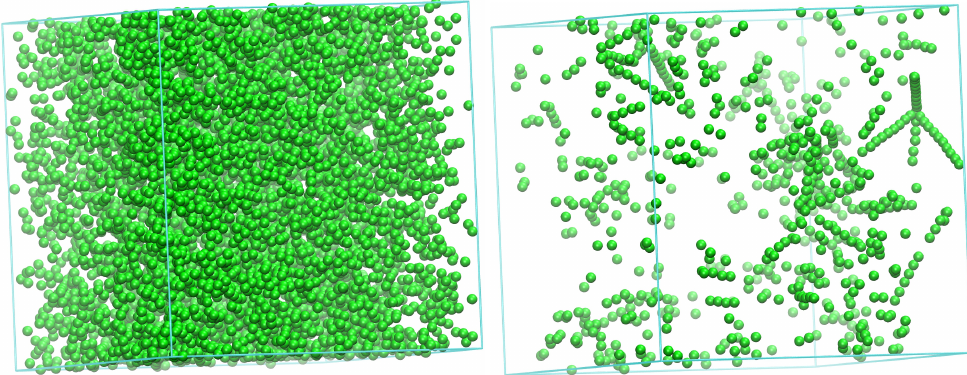
Figure 4. Spatial distribution of FIV sites in ( Left ): Region I (frame 125, S FIV = 0.129) and ( Right ): Region II (frame 1622, S FIV = 0.014). Image created with the VMD visualization software [111].